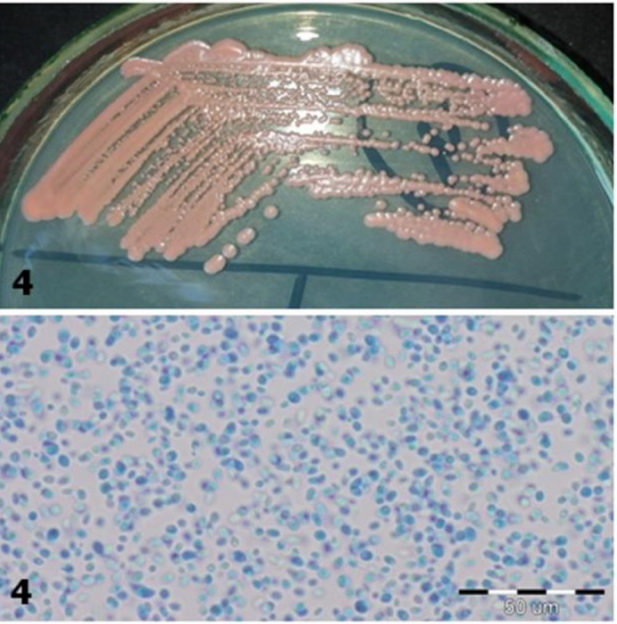
Figure 2. Strain 4-morphology on Sabouraud 2 with chloramphenicol medium and 40 × zoom (Lactophenol Cotton Blue; private